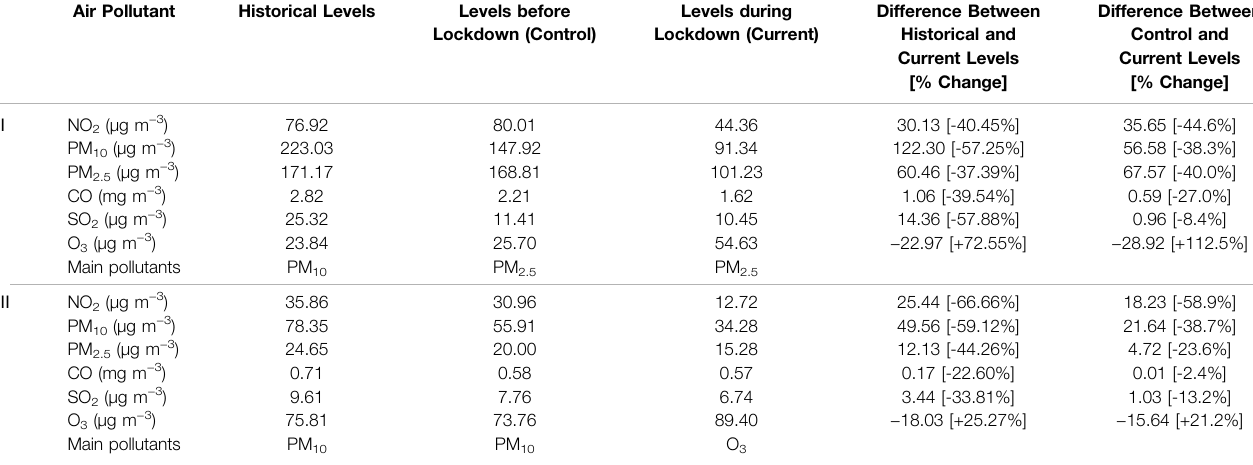
TABLE 1 | Mean concentrations of air pollutants in Urumqi during the winter (I) and summer (II)